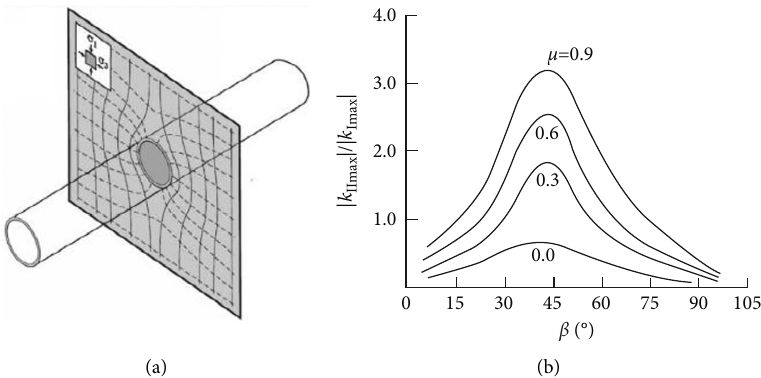
Figure 4: The change of principal stress direction of surrounding rock and the influence of principal stress direction on intensity factor. (a) Principal stress vector of surrounding rock during tunnel excavation [16]. (b) Influence of principal stress direction on intensity factor [15].